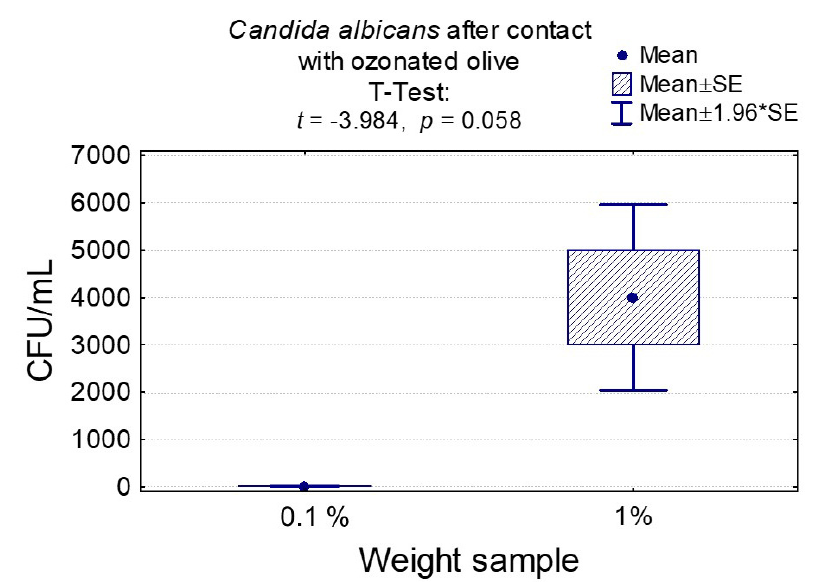
Figure 8. Average CFU / mL value and standard deviation (M ± SD) for Candida albicans after temporary contact with olive ozone in groups di ff ering in weight and significance of test result. Incubation took 24 h.